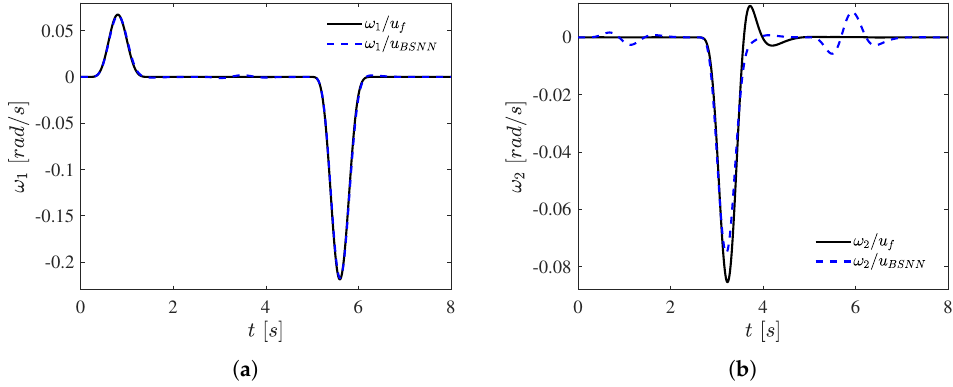
Figure 10. Speed deviation of ( a ) generator 1; ( b ) generator 2.